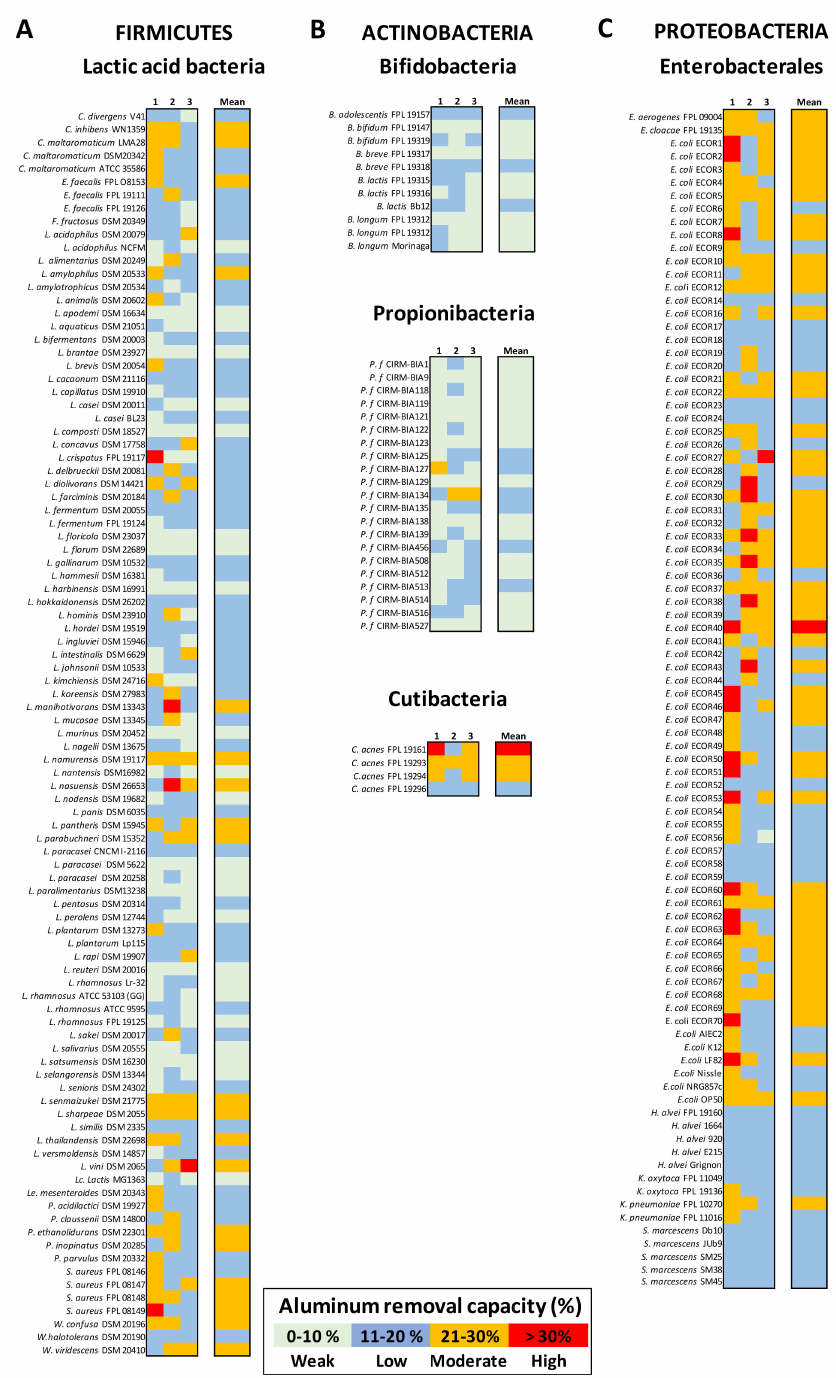
Figure 4. Al(III) removal capacity of bacteria from distinct taxonomic phyla. Panel ( A ): LAB. Panel ( B ) Actinobacteria, comprising bifidobacteria, propionibacteria, and cutibacteria. Panel ( C ): Proteobacteria, such as the Enterobacterales. Metal removal capacity was defined as the mean ± SD percentage of the initial quantity of metal in solution, in triplicate experiments. Here, the Al removal capacity is color-coded as weak (0 to 10%: pale green), low (11 to 20%: blue), moderate (21 to 30%: orange), or high (over 30%: